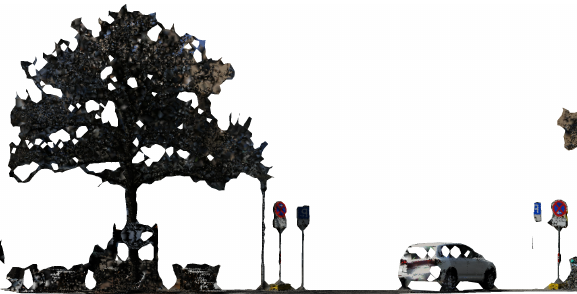
Figure 7: Resulting texture image representing a single layer